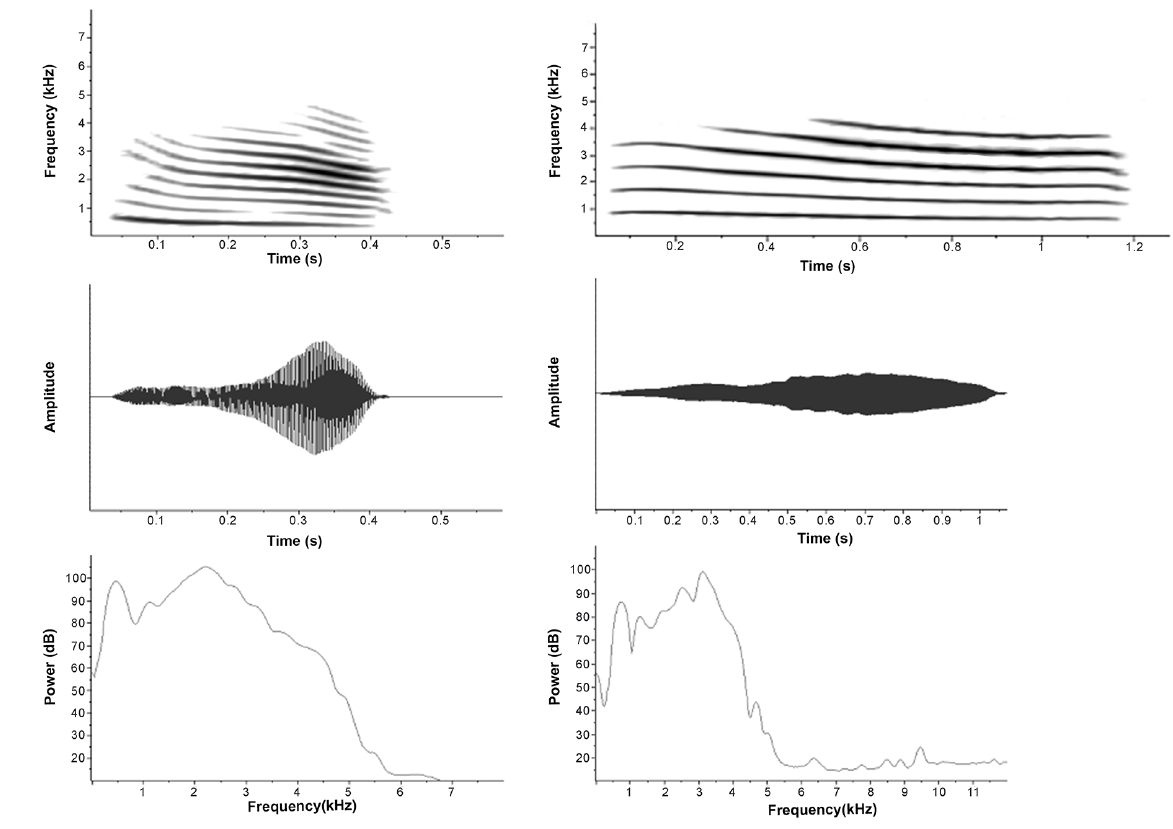
Figure 4. Power spectrum of the first third (left) and the final third (right) of an advertisement call of P. aff. albonotatus (above) and P. santafecinus